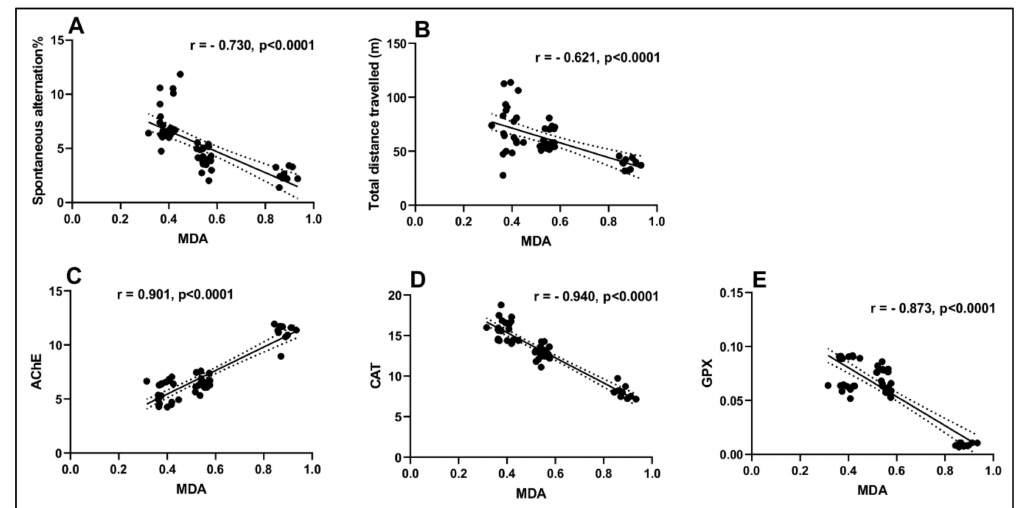
Figure 7. Correlation analyses between behavioral and biochemical parameters (Pearson’s correlation, n = 10): ( A ) spontaneous alternation% vs. MDA: r = − 0.730, p < 0.0001; ( B ) total distance travelled vs. MDA: r = − 0.621, p < 0.0001; ( C ) AChE vs. MDA: r = 0.901, p < 0.0001; ( D ) CAT vs. MDA: r = −